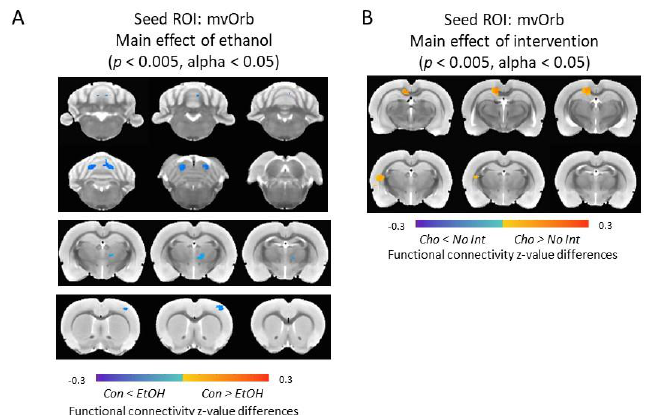
Figure 8. Alterations of mvOrb functional connectivity in male rats. (A) Main effect of EtOH was detected in ventral lateral/medial nucleus of thalamus, primary somatosensory cortex, the external cortex of the inferior colliculus and cerebellar areas. (B) Main effect of intervention was detected in the retrosplenial cortex and caudate putamen. Color code: connectivity differences between Control (Con) and Ethanol (EtOH) animals. ROI=Region of Interest, mvOrb=medial-ventral Orbitofrontal Cortex.